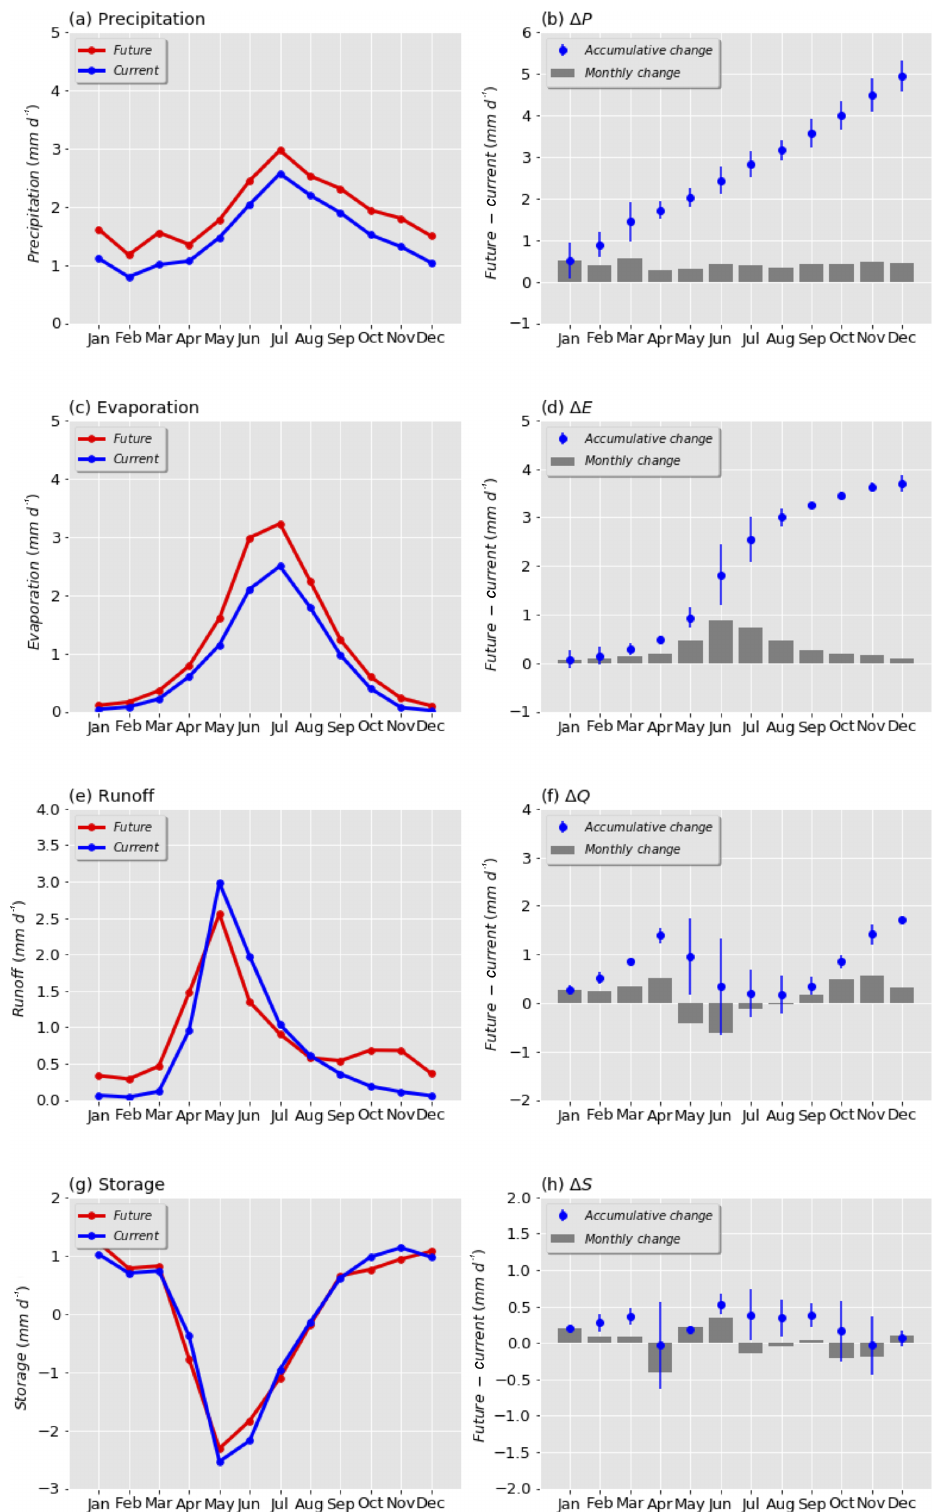
Figure 4. The surface water budget (mmd − 1 ) in MRB for the WRF–CTL and the WRF–PGW simulations: (a) P , (b) changes in P , and its accumulated changes in P ; (c) ET, (d) changes in ET, and its accumulated changes in ET; (e) runoff, (f) changes in runoff, and its accumulated changes in runoff; and (g) storage, (h) changes in storage, and its accumulated